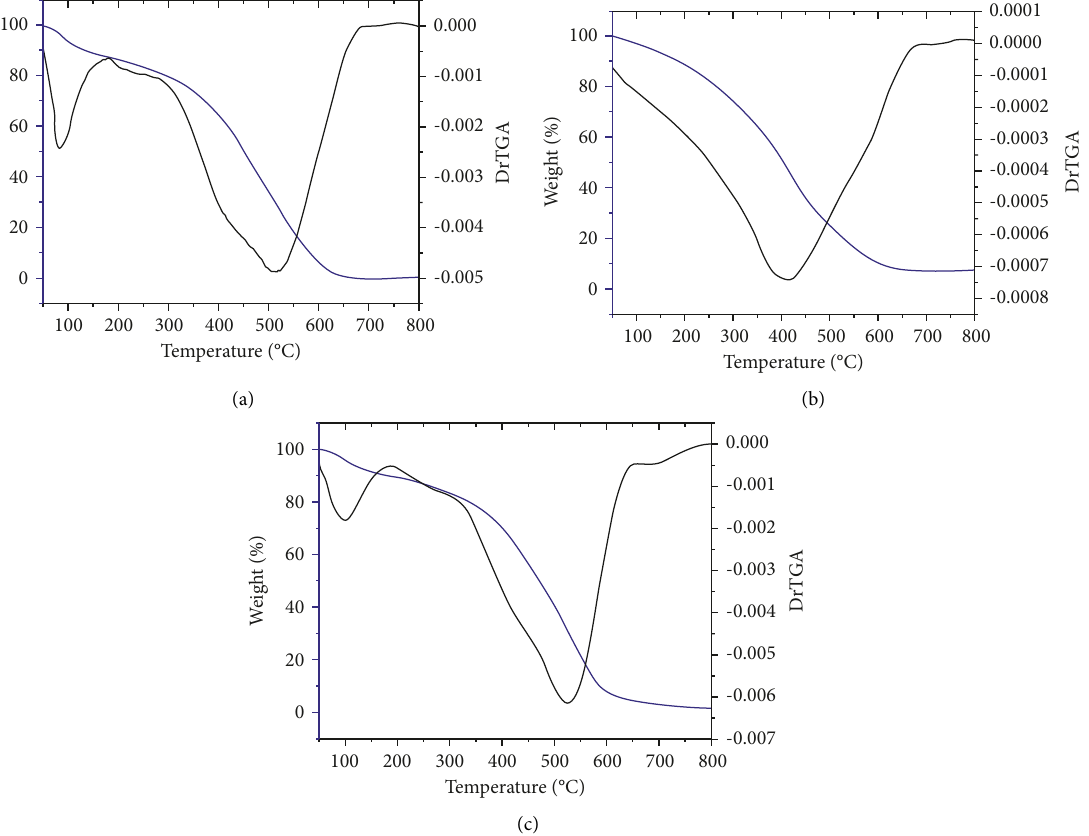
Figure 5: Termal analysis (TGA/DTA) patterns for the (a) Cu(II), (b) Co(II), and (c) Fe(II)